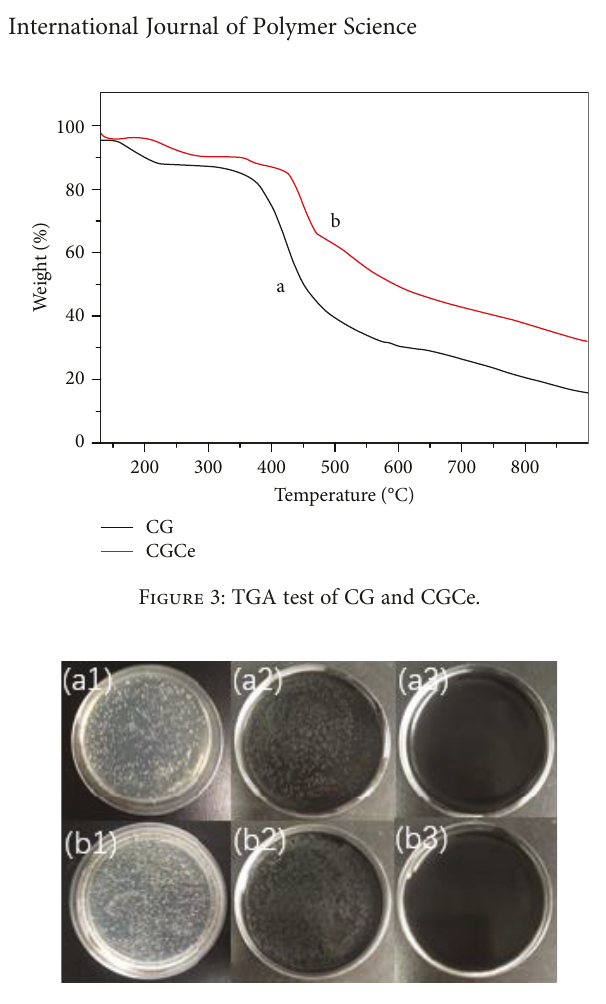
Figure 4: Antimicrobial qualitative test: ((1) gelatin; (2) CG; (3) CGCe; (a) S. aureus ; (b) E. coli ).